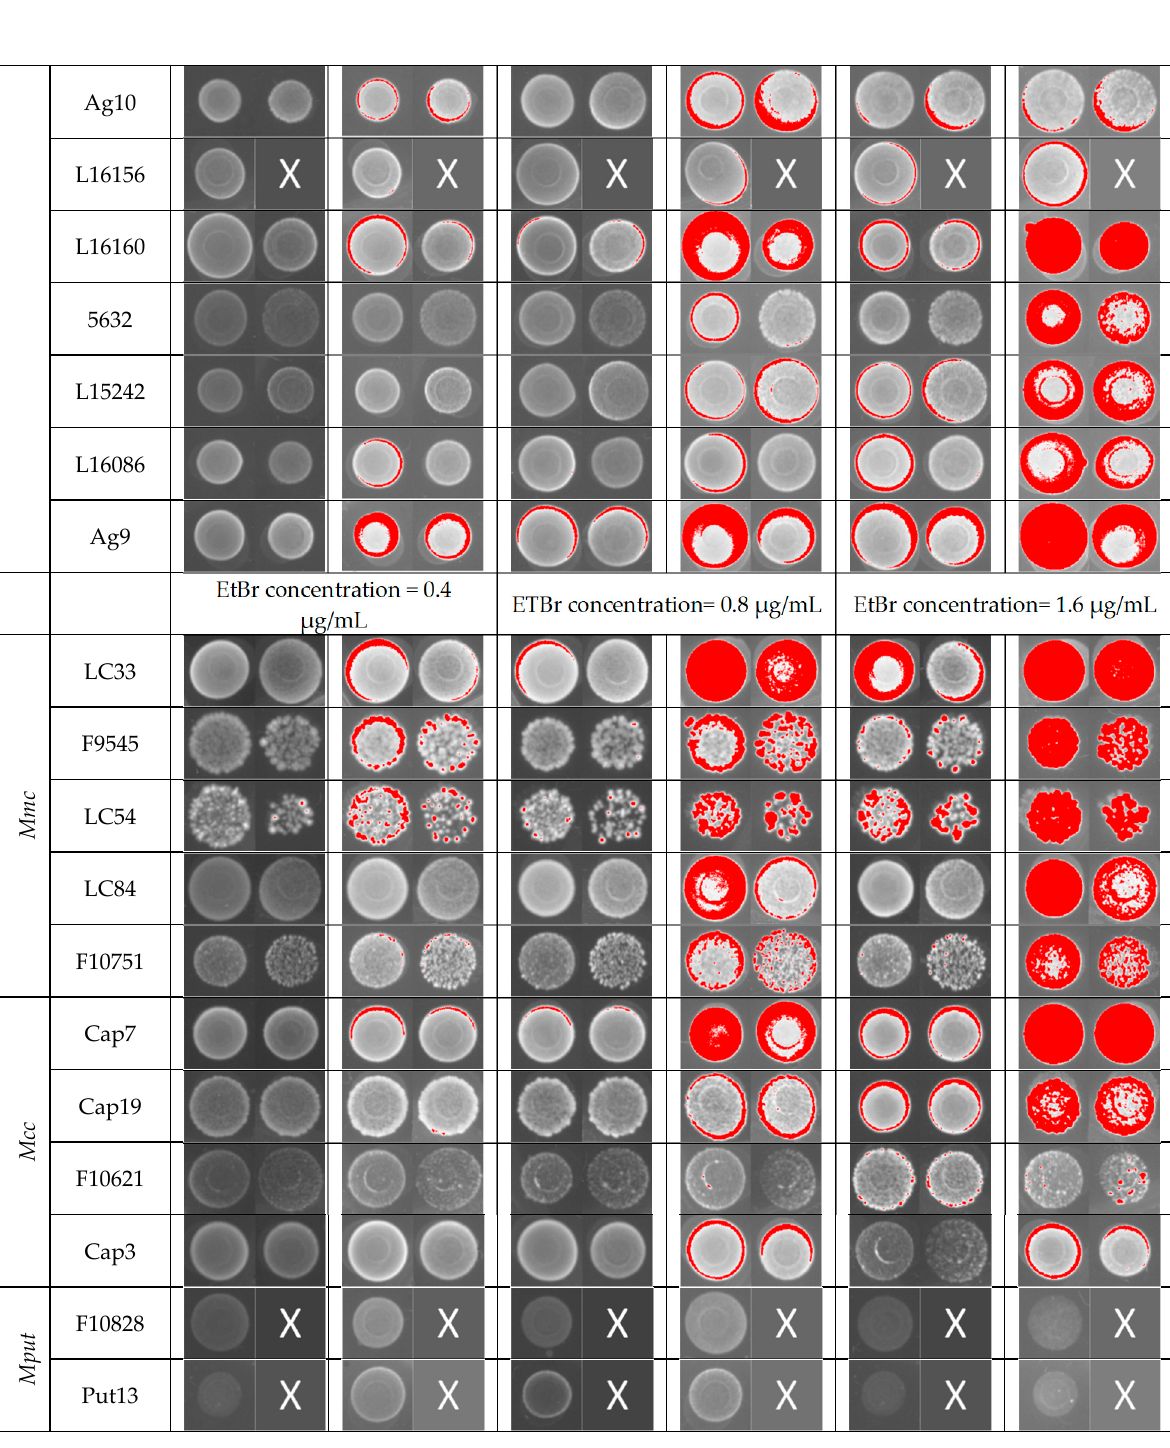
Figure 1. Evaluation of efflux activity of Mycoplasma isolates using the ethidium bromide (EtBr) agar method. A volume of 1 µL of each culture dilution (10 8 and 10 7 cfu/mL for M. agalactiae and 10 7 and 10 6 cfu/mL for M. mycoides cluster, or related, isolates) was incubated for 72 h at 37 °C and a further 24 h at either 37 °C or 4 °C on agar plates containing different EtBr concentrations. Fluorescence was detected under UV light (the appearance of pixel saturation resulted in a red coloration of bacterial spots). “X” means that only one concentration of inoculum was studied (10 8 cfu/mL for M. agalactiae and 10 7 cfu/mL for M. mycoides cluster, or related strains). Mmc , M. mycoides susbp. capri ; Mcc , M. capricolum subsp. capricolum , Mput ., M. putrefaciens .